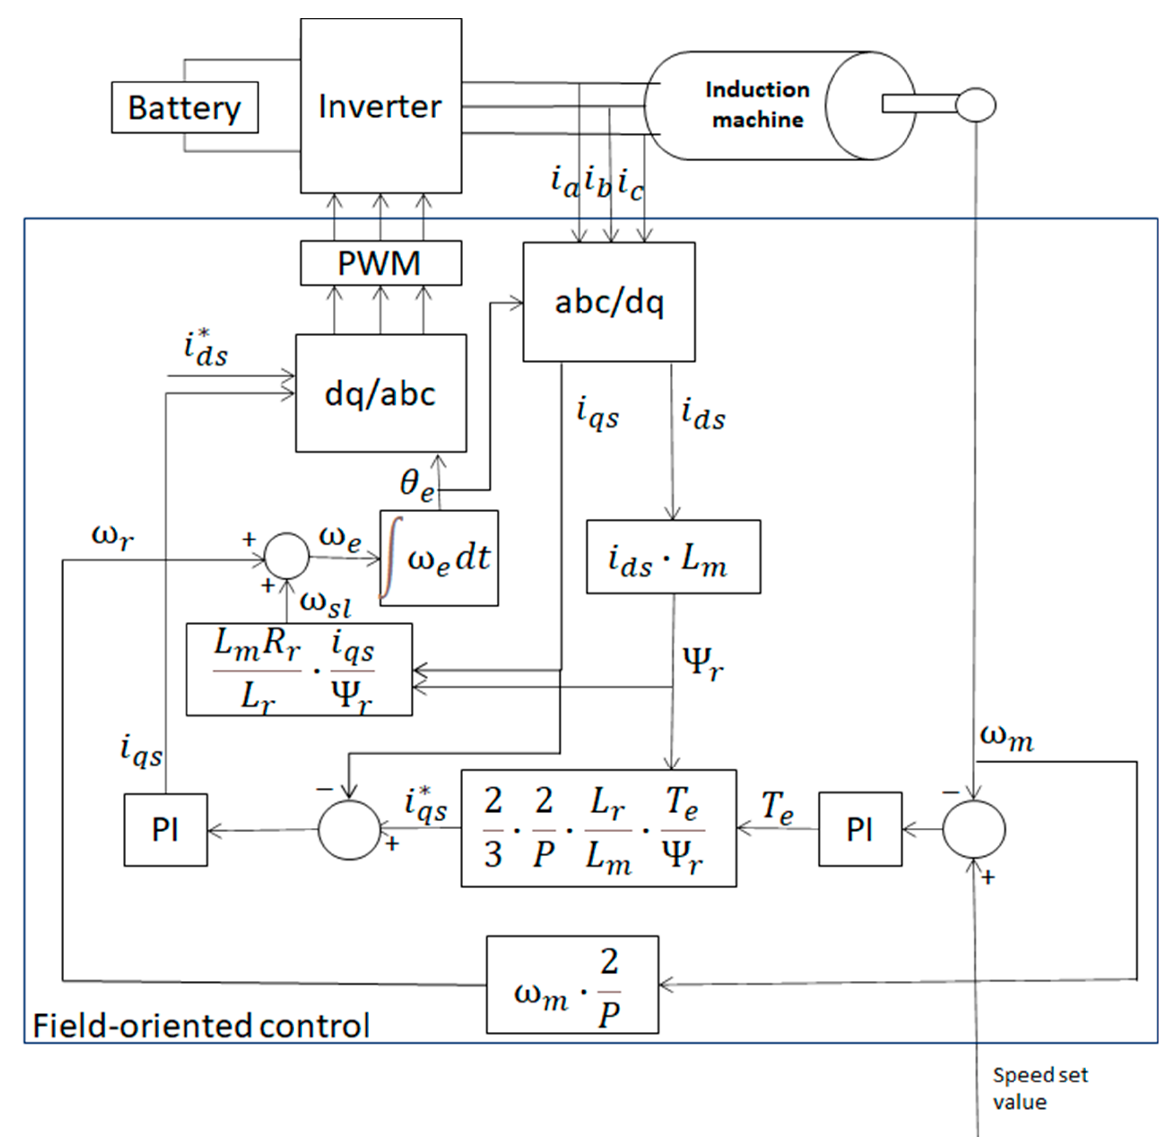
Figure 6. Vector-controlled induction machine system. Reproduced from [18] with permission from IEEE.